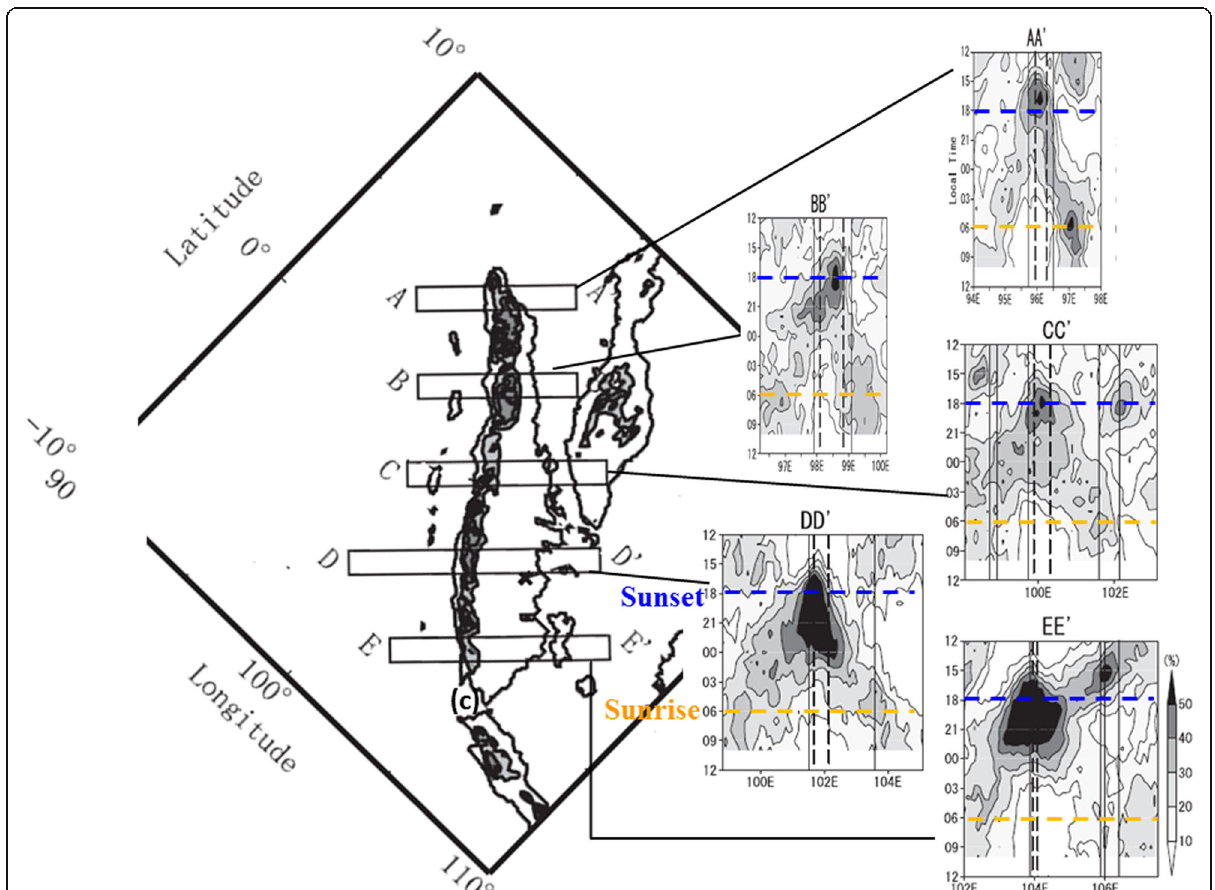
Fig. 11 Geographic variability of diurnal cycle migrations (Hovmöller diagrams) of high GMS cloud top areas, analyzed for five cross-sections approximately perpendicular to the western coastline of Sumatera during May 2001 – April 2002 (Sakurai et al.